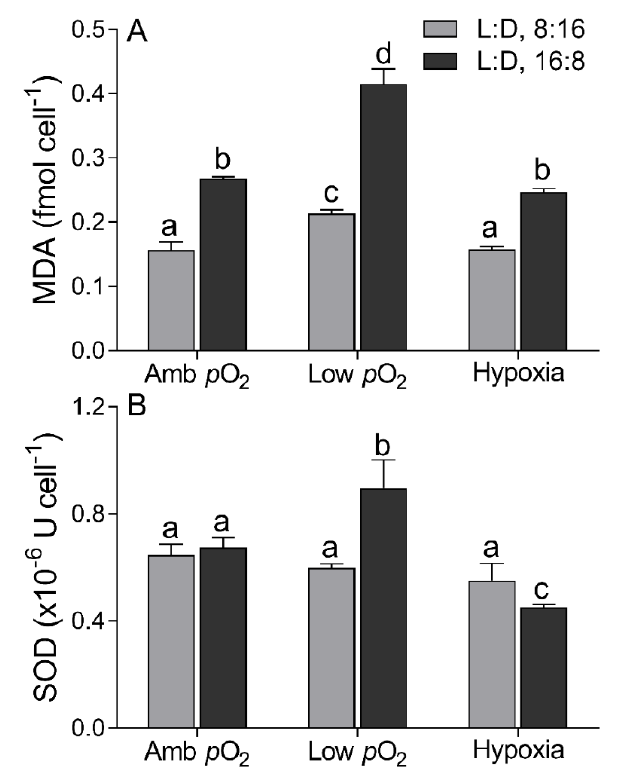
Figure 4. Cellular malondialdehyde concentration (( A ), MDA, fmol cell − 1 ) and superoxide dismutase activity (( B ), SOD, × 10 − 6 U cell − 1 ) of T. pseudonana grown under 8:16 and 16:8 L:D cycles, under am-